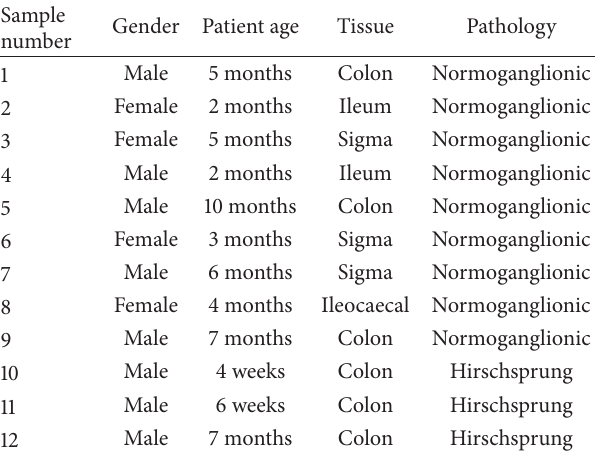
Table 1: Human gut